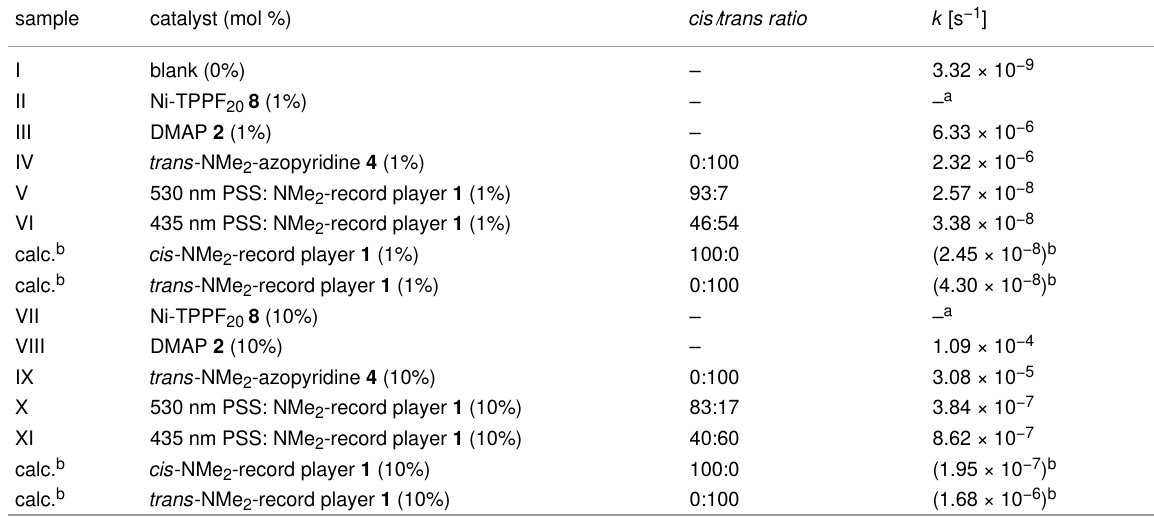
Table 1: Pseudo-first order rate constants ( k ) of the Henry reaction (Scheme 2) in the presence of different catalysts and reference compounds. Calculated rate constants are based on the assumption of complete isomerization and no intermolecular coordination. The concentration of the cata- lyst is given in mol % (in parentheses) with respect to the initial nitrobenzaldehyde ( 6 ) concentration.